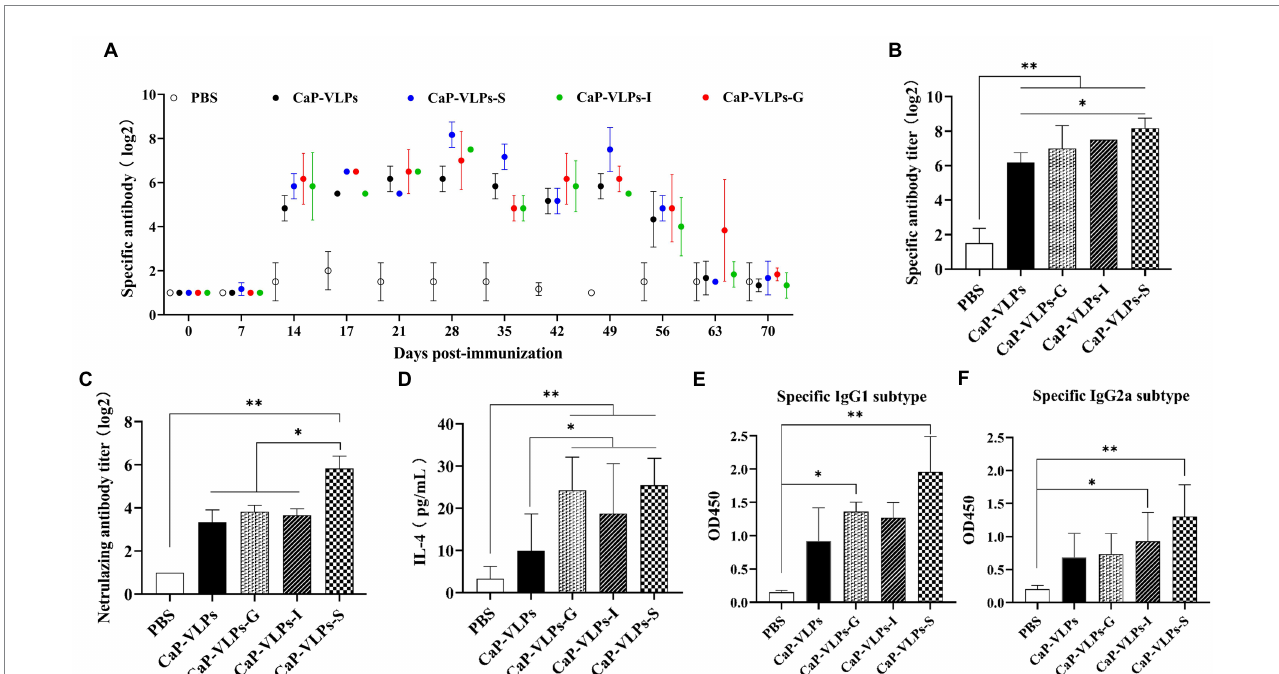
FIGURE 3 FMDV-specific humoral immune responses induced by CaP-VLPs in mice. (A) Changes in antibody titers against type-O FMDV were determined by LPBE assay after vaccination. (B) Titers of IgG of experimental groups on day 28 after the first immunization. (C) Titers of neutralizing antibodies of experimental groups on day 28 after the first immunization. (D) Content of IL-4 in the serum of mice on day 28 after the first immunization. (E) Content of the IgG1 subtype in serum on day 28 after the first immunization. (F) Content of the IgG2a subtype in serum on day 28 after the first immunization. Asterisks indicate significant differences (* p < 0.05, ** p <